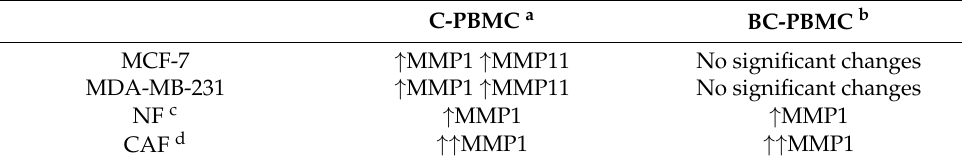
Table 1. Summary of the MMP1 and MMP11 gene expression in PBMC after co-culture.